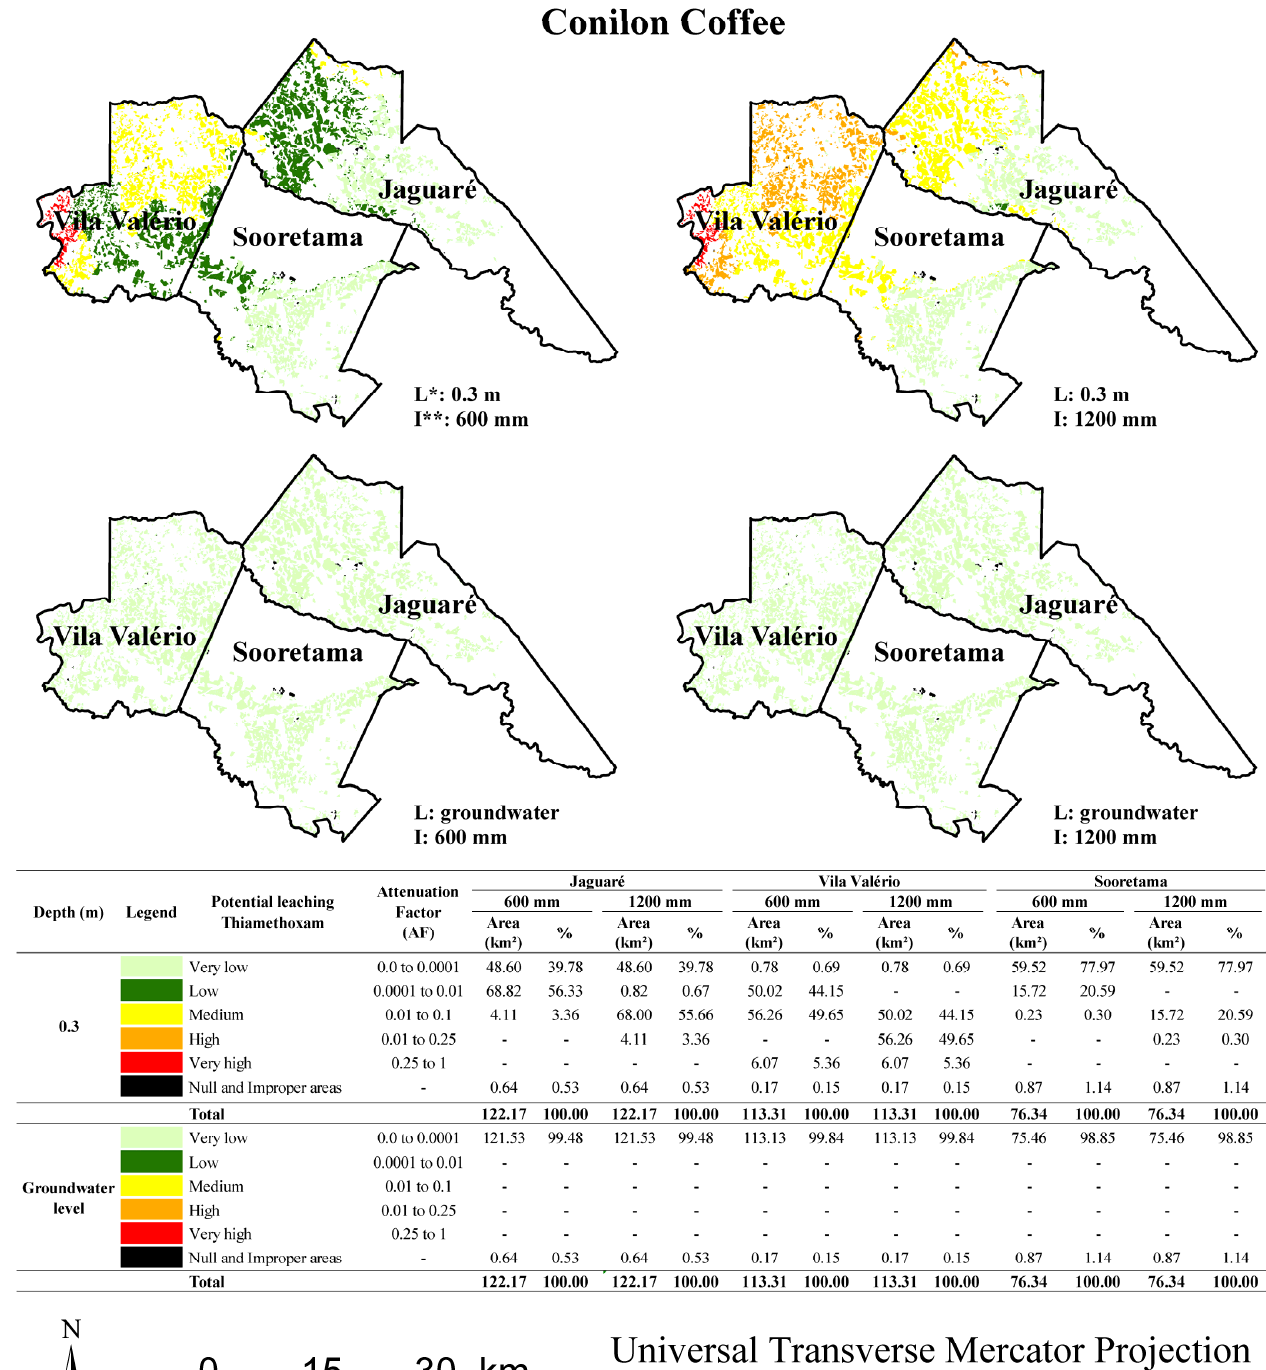
Figure 4. Attenuation Factor (AF) of active ingredient sulfentrazone evaluated for an extended study area cultivated with conilon coffee ( Coffea canephora Pierre ex Froehner) for the municipality of Jaguaré, ES, Brazil. * L: Groundwater depth and ** I: Irrigation.